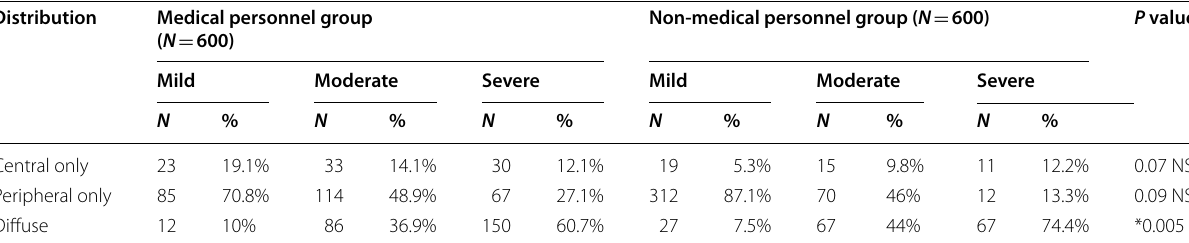
* p value < 0.05, ** p value < 0.01 Table 8 Comparison between medical personnel and non-medical personnel groups, regarding distribution of lung involvement ( N 1200) =